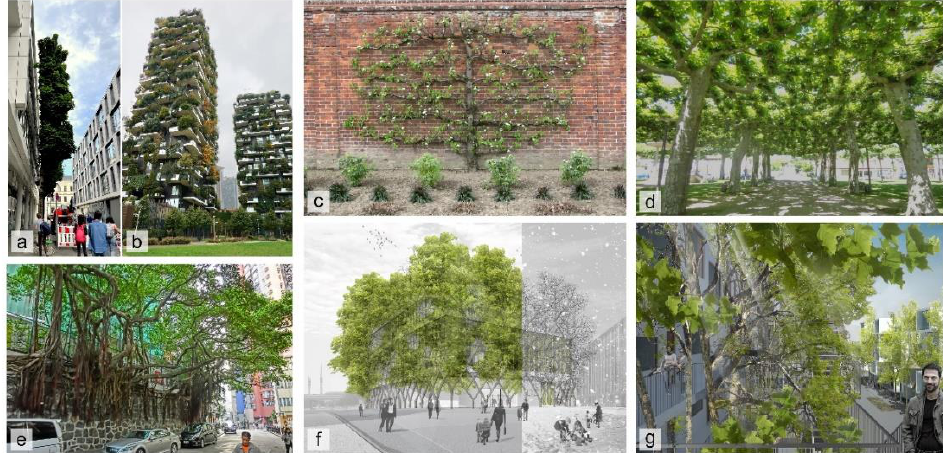
Figure 1. Challenges and potentials of trees in dense urban areas. (Image ( b – e ) are retrieved from the internet under Creative Commons licenses. Image ( a,f,g ) are own images).